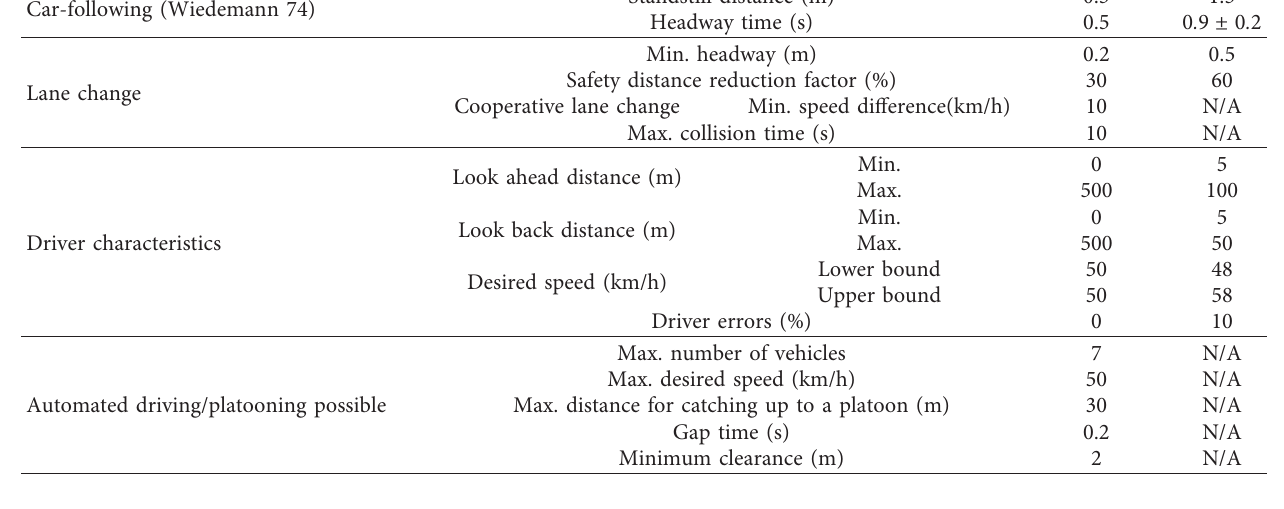
Table 1: Parameters for modelling AVs and